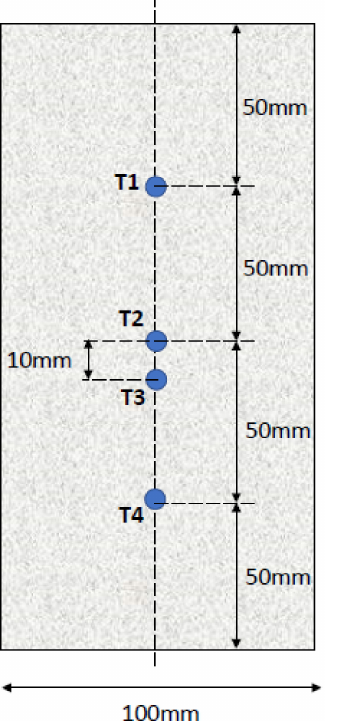
Figure 3. Typical LFC cylinder sample with thermocouples